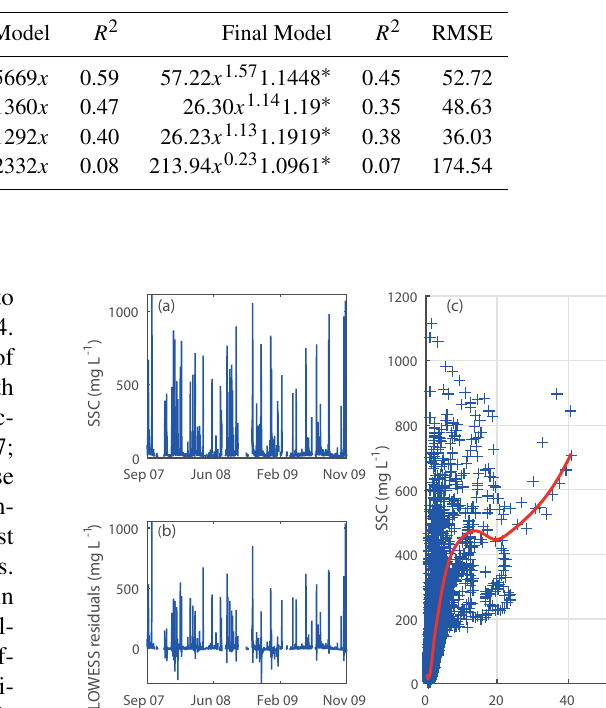
Table 2. Summary of the developed empirical models for the prediction of suspended sediment concentrations from normalized discharge. Tv is the normalized discharge threshold value for model partition, set at 4.6ms − 1 .